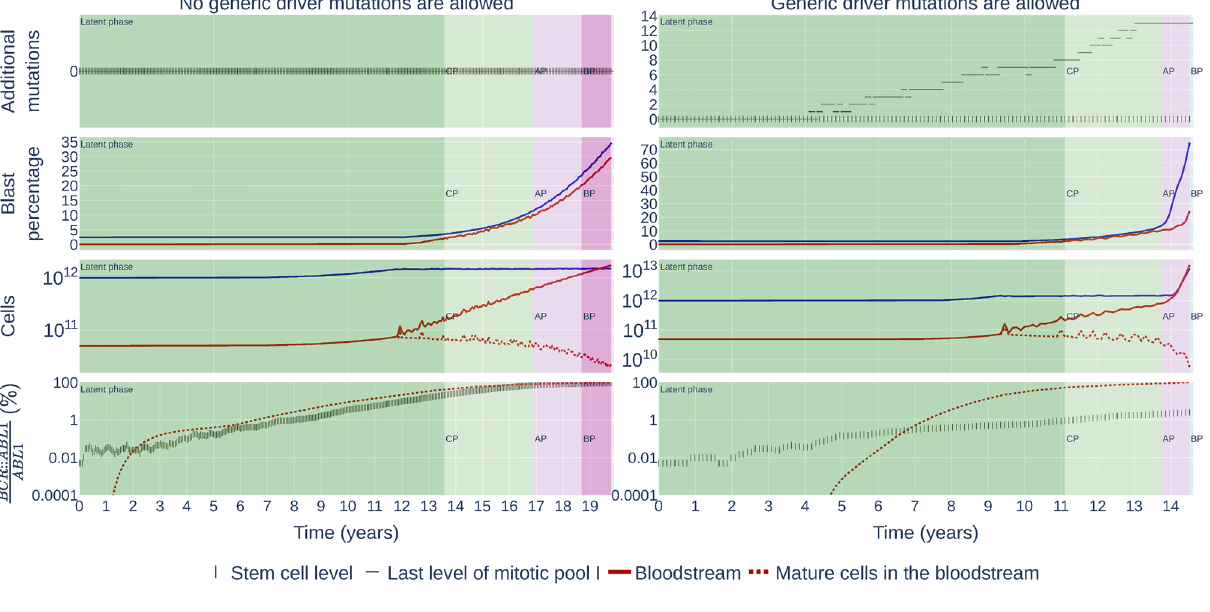
Figure 3. Individual instances of a computer simulation for two different progression modes. The left row corresponds to a simulation in which the mutant cells can only acquire the BCR::ABL1 gene and no generic mutations. The simulation parameters are [mutation rate = 0, HSC divisions per year = 6.31, BCR::ABL1 mutation strength = 0.23]. The right row depicts a simulation with additional driver mutations allowed. The simulation parameters are [mutation rate = 9 × 10 −4 , HSC divisions per year = 1.18, BCR::ABL1 mutation strength = 0.67]. Tumor load is characterized by the BCR::ABL1 / ABL1 transcript